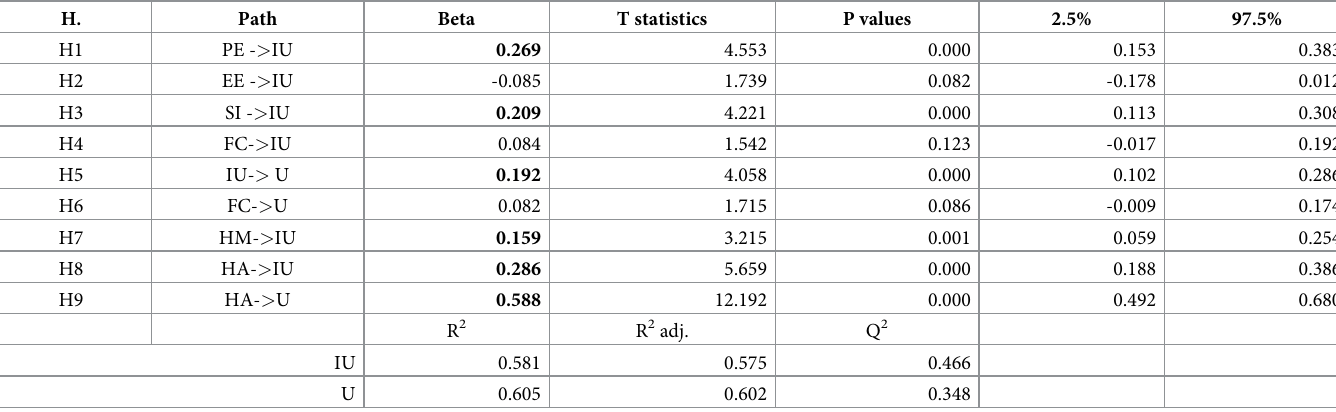
Table 9. Path coefficients of global model. H.